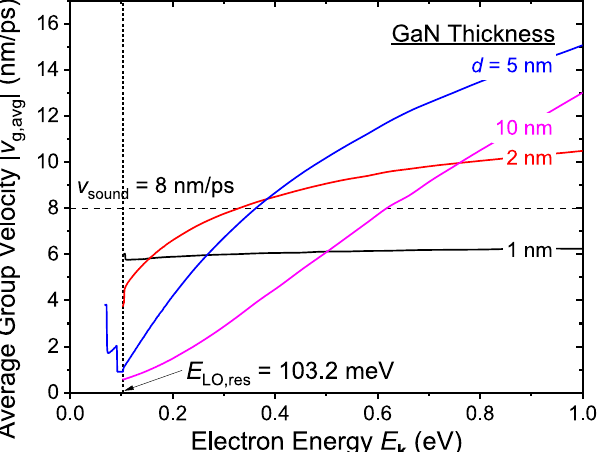
Figure 7. Average group velocity of the emitted interface and confined mode phonons with different GaN thickness d = 1, 2, 5, and 10 nm as a function of electron energy E k is shown. As a reference, the longitudinal acoustic phonon propagation velocity along the c -axis [0001] is indicated as the horizontal dashed line. At low energies right above E LO,res = 103.2 meV, heterostructures with thinner GaN thickness d shows a